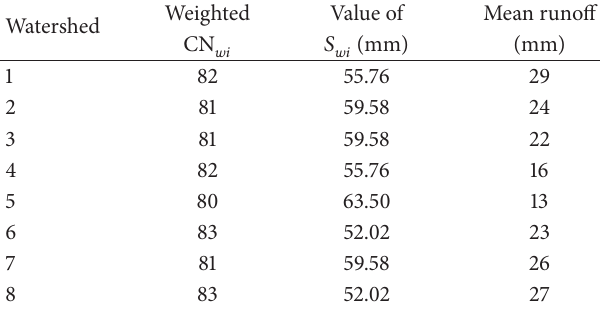
Table 3: Weighted CN 𝑤𝑖 value, 𝑆 𝑤𝑖 , and monthly mean runoff for each